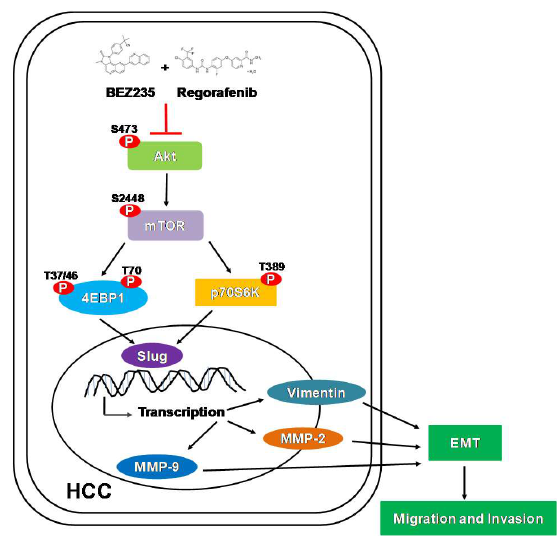
Figure 6. Model depicting the anti-tumor effect of the combined treatment with BEZ235 and regorafenib in HCC cells. The combined treatment suppressed HCC cell migration and invasion through inhibition of the Akt/mTOR signaling pathway.